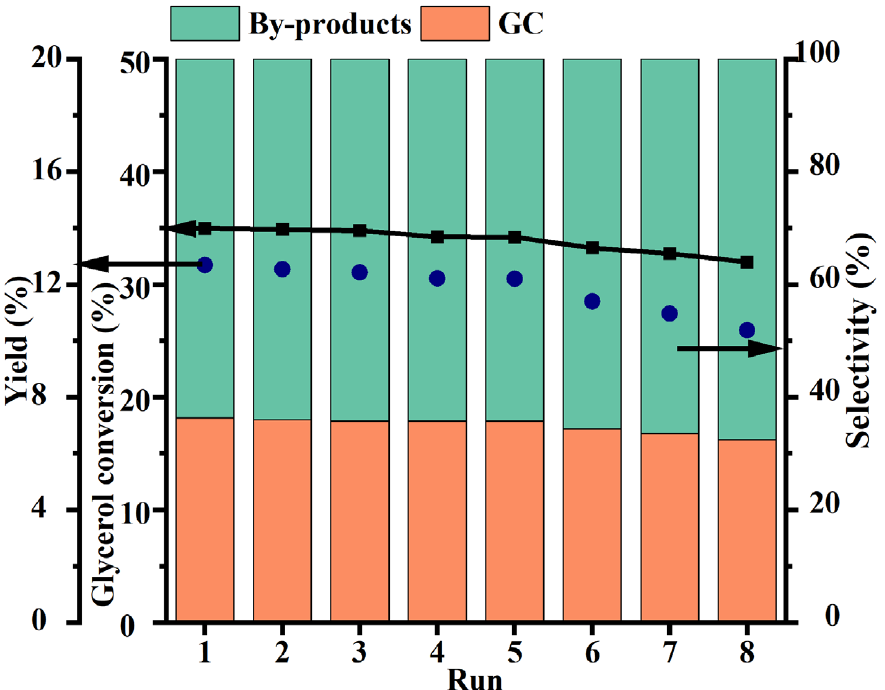
Figure 5. Stability of the Co/ETS-10 catalyst (reaction conditions: 170 °C, 4 MPa, 0.25 g catalyst, 6 h, and 5 mL CH 3 CN).